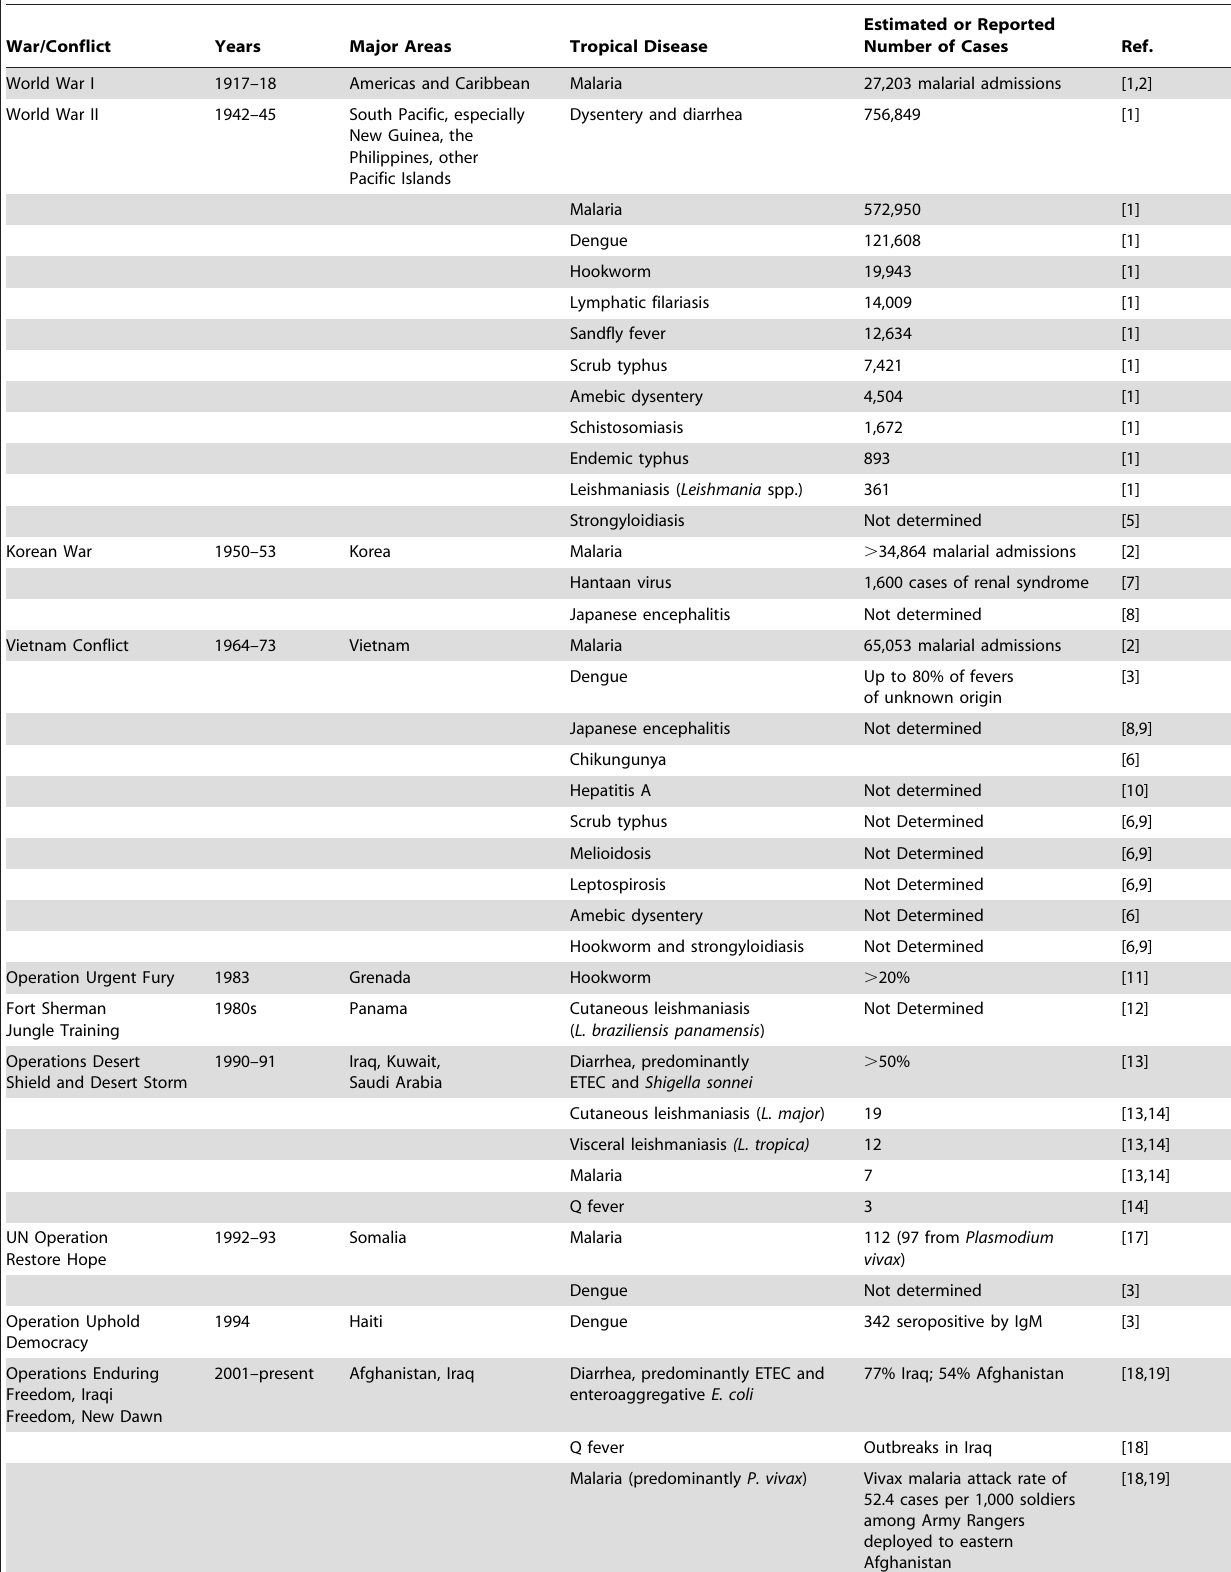
Table 1. Major tropical diseases in US military wars and conflicts.